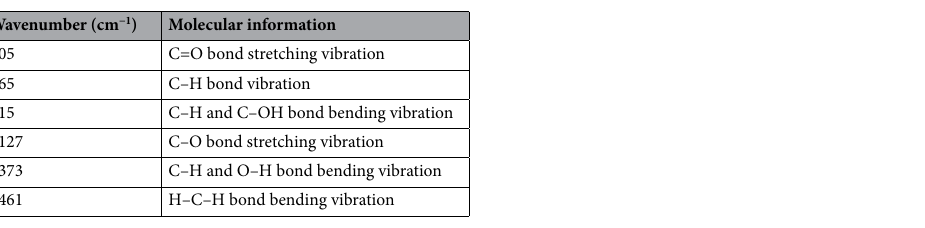
Table 1. Peak positions and assignments of main Raman bands 8 .